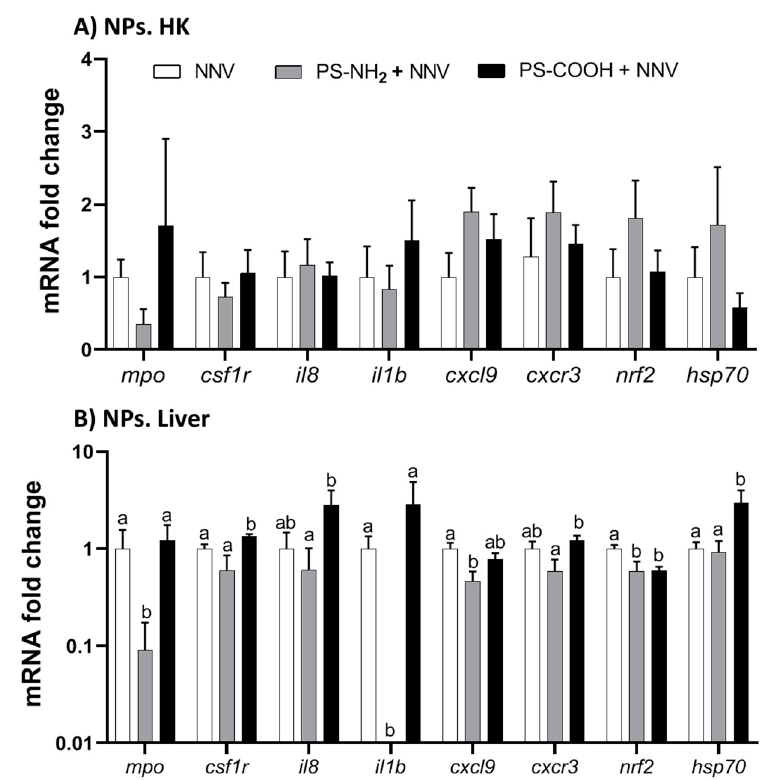
Figure 2. Exposure to functionalized polystyrene nanoplastics (NPs) slightly alters the transcrip- tional profile in European sea bass. European sea bass juveniles were intraperitoneally injected with phosphate buffer (PBS; Control) or with 1 μ g mL − 1 of 50 nm functionalized polystyrene NPs (PS-NH 2 and PS-COOH), and the transcription profile in the head-kidney ( A ; HK) and liver ( B ) was evaluated after 96 h by real-time PCR. Lowercase letters denote significant differences between NP-exposed and control treatments according to ANOVA and Tukey’s post-hoc tests ( p < 0.05). nrf2 , nuclear factor (erythroid-derived 2)-like 2; csf1r , macrophage colony-stimulating factor 1 receptor; cxcl9 , CXC chemokine 9; cxcr3 , CXC motif chemokine receptor 3; hsp70, heat-shock protein 70; and isg15, interferon-stimulated gene 15.